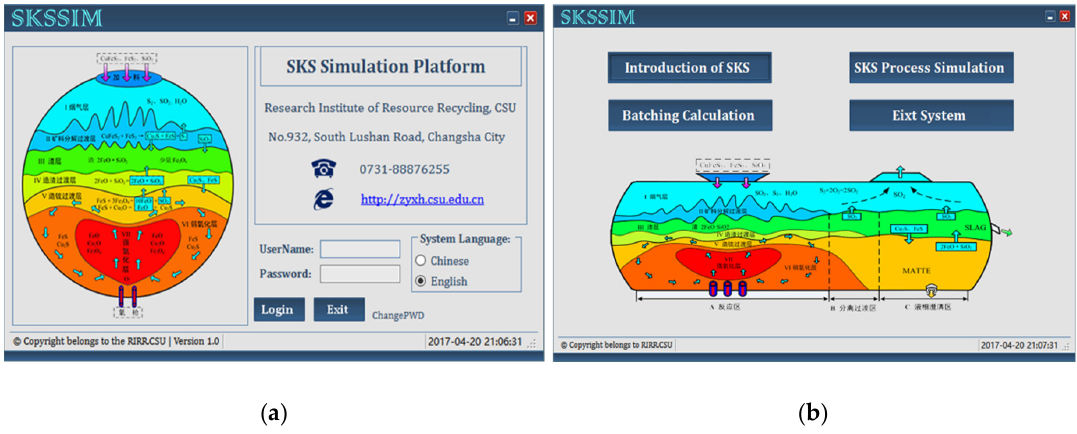
Figure 2. Login screen and navigation interface of SKSSIM: ( a ) login screen; ( b ) navigation interface.